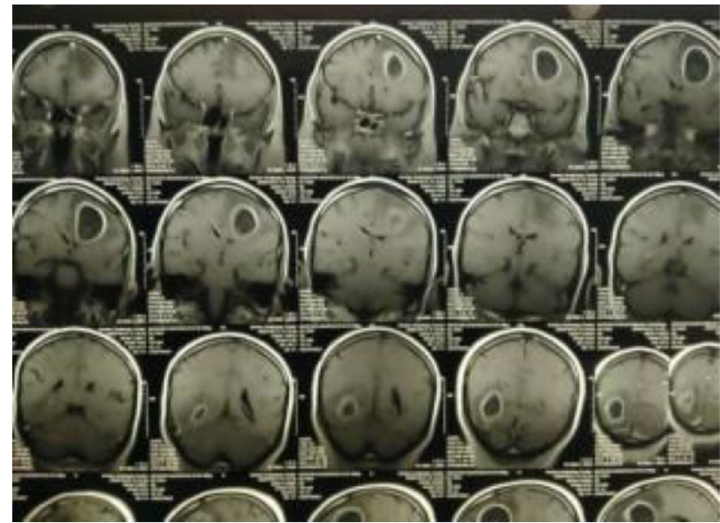
Fig. 3 MRI with contrast sagittal and coronal sections show left frontal and right parietal—intra-axial hypodense brain lesions with a margin of